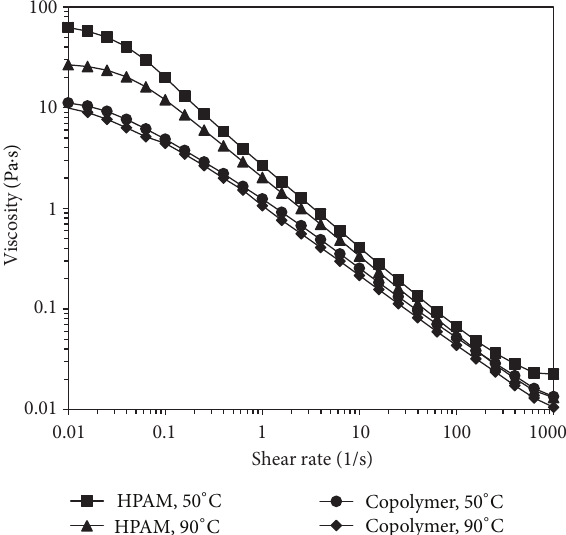
Figure 8: Effect of temperature on viscosity of 0.25% copolymer at different surfactant concentration.